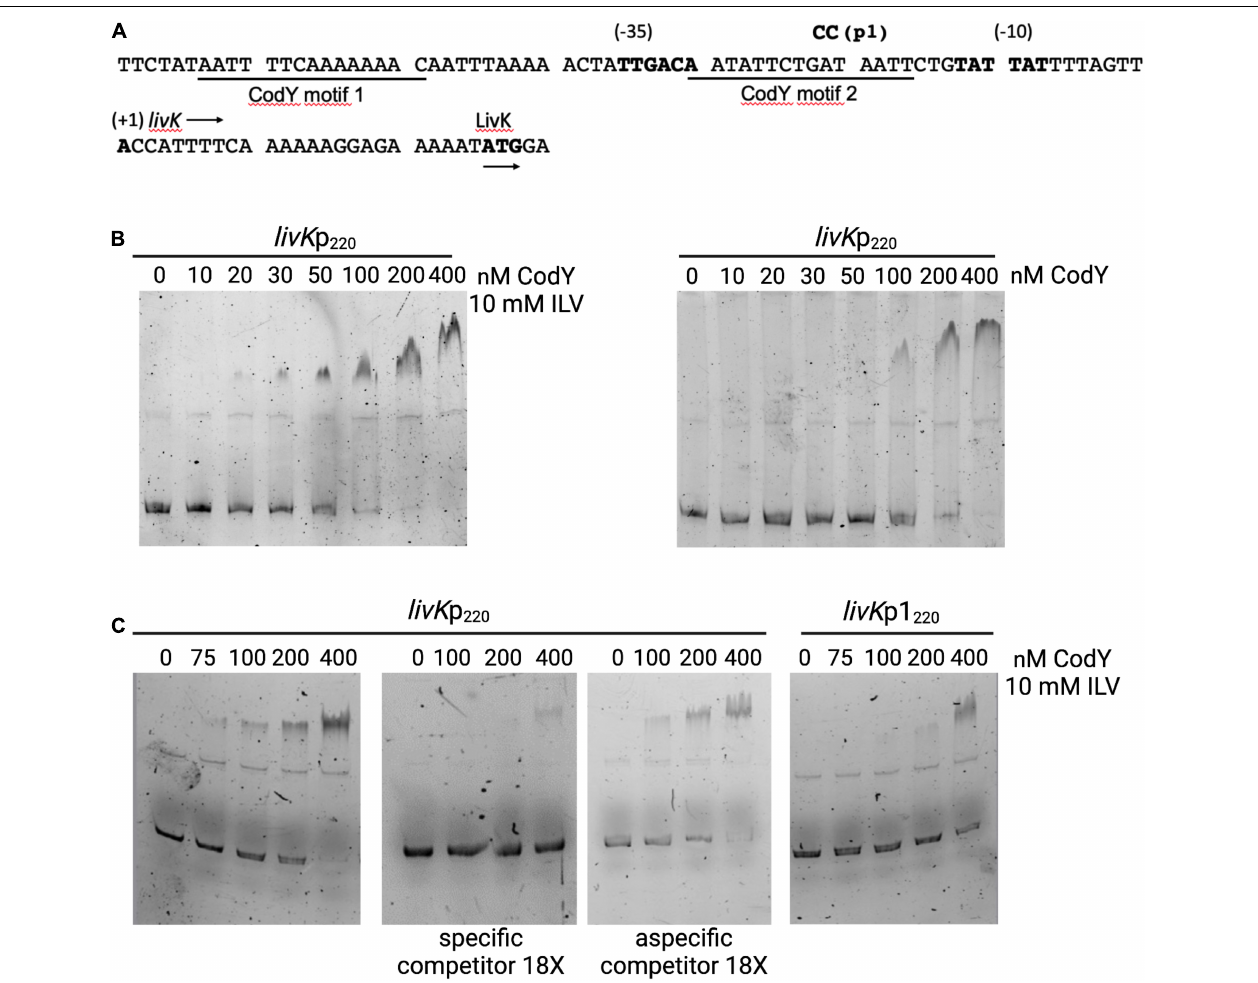
FIGURE 7 | CodY binds to the livK promoter. (A) Sequence (5’ to 3’) of the livK regulatory region. Coordinates are reported with respect to the transcription start point (Mazzuoli et al., 2021). The transcription start site, − 10 and − 35 promoter regions, and the starting codon of the livK CDS are in boldface. The directions of transcription and translation are indicated by the horizontal arrows. The sequences of the two CodY-binding motifs are underlined. The mutated nucleotides (p1) are shown above the sequence. (B) Electrophoretic mobility shift assays (EMSA) for binding of CodY to the livK regulatory region. CodY and the WT livK p 220 fragment were incubated in the presence or absence of 10 mM each isoleucine, leucine, and valine (ILV). When ILV were included in the reaction mixture, the non-denaturing polyacrylamide gel and the electrophoresis buffer were supplemented with 10 mM ILV. (C) EMSA performed with the WT livK p 220 and mutated livK p1 220 fragments. Specificity of binding was evaluated by performing the experiment with the WT fragment in the absence or presence of a specific (unlabeled livK p 220 fragment) or non-specific competitor. DNA-Protein mixtures were separated on 5% non-denaturing gel in presence of 10 mM